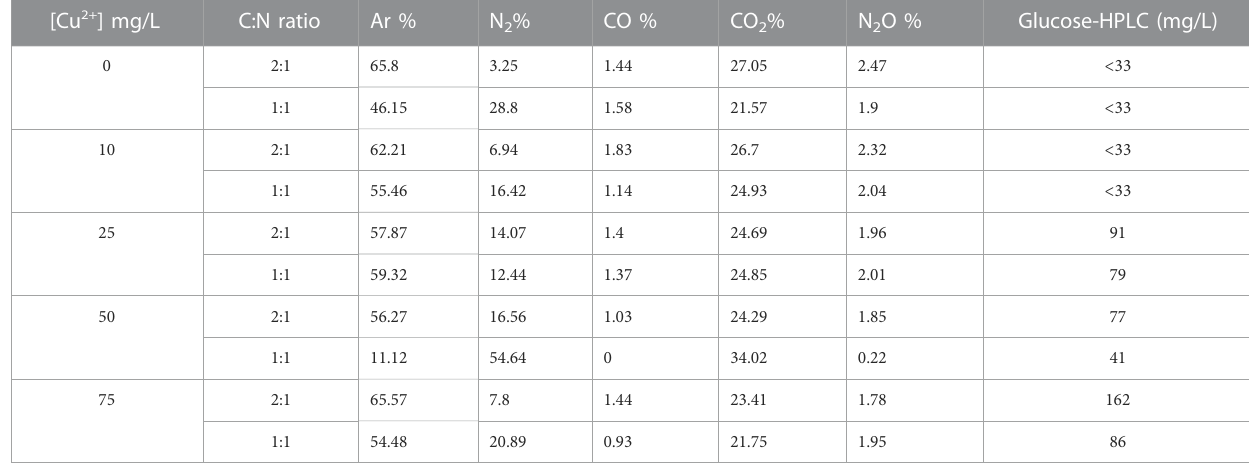
TABLE 3 GC and HPLC analysis results with biogenic gas composition and residual glucose concentrations from the cultures with copper and glucose. [Cu 2+ ]